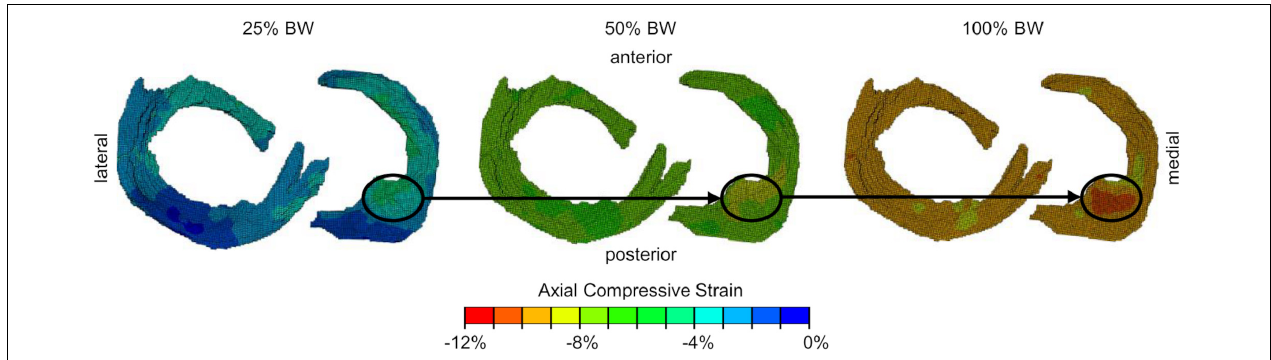
FIGURE 5 | Axial compressive strain fields (from proximal view) of one representative meniscus and its attachments for all three load levels [25%, 50%, 100% body weight (BW)]. Local regions (black circles) with comparably high compressive strains are maintained when applying different load levels.